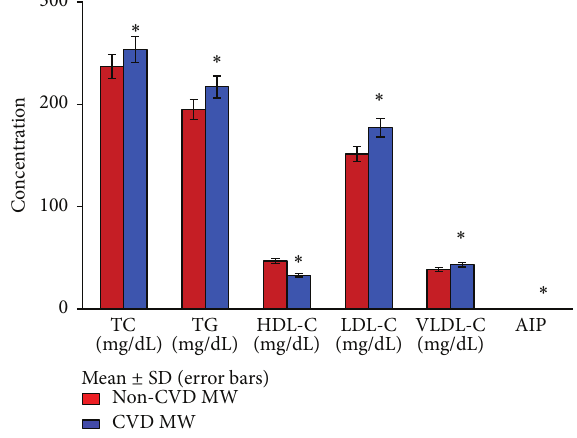
Figure 2: Levels of lipid profile in hyperlipidemic CVD and non-CVD menopausal women. ∗ 𝑝 < 0.05 significant difference observed in the levels of TC, TG, HDL-C, LDL-C, VLDL-C, and AIP between hyperlipidemic CVD and non-CVD menopausal women. Note . Due to small range of AIP values (mean ± SD), the bars are not visible (AIP value in non-CVD MW is 0.26 ± 0.09 and in CVD MW it is 0.46 ±